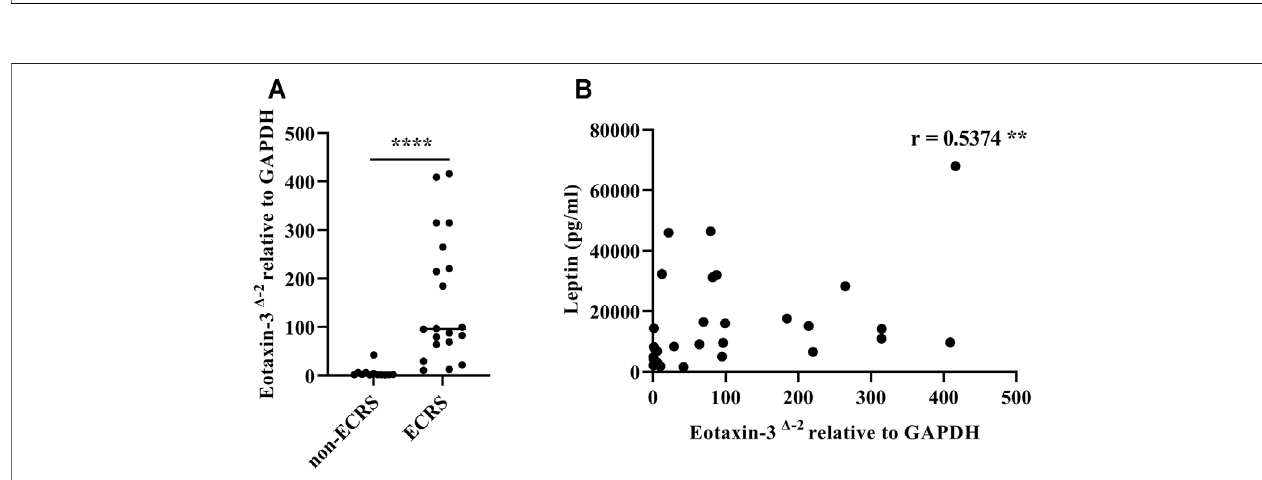
FIGURE 3 | Eotaxin-3 gene expression in nasal polyp tissue. (A) Comparison of eotaxin-3 gene expression in nasal polyps and (B) correlation with leptin levels in serum. ( n (cid:1) 32). Correlations were assessed using Spearman ’ s rank correlation test. ** p < 0.01; **** p < 0.0001.